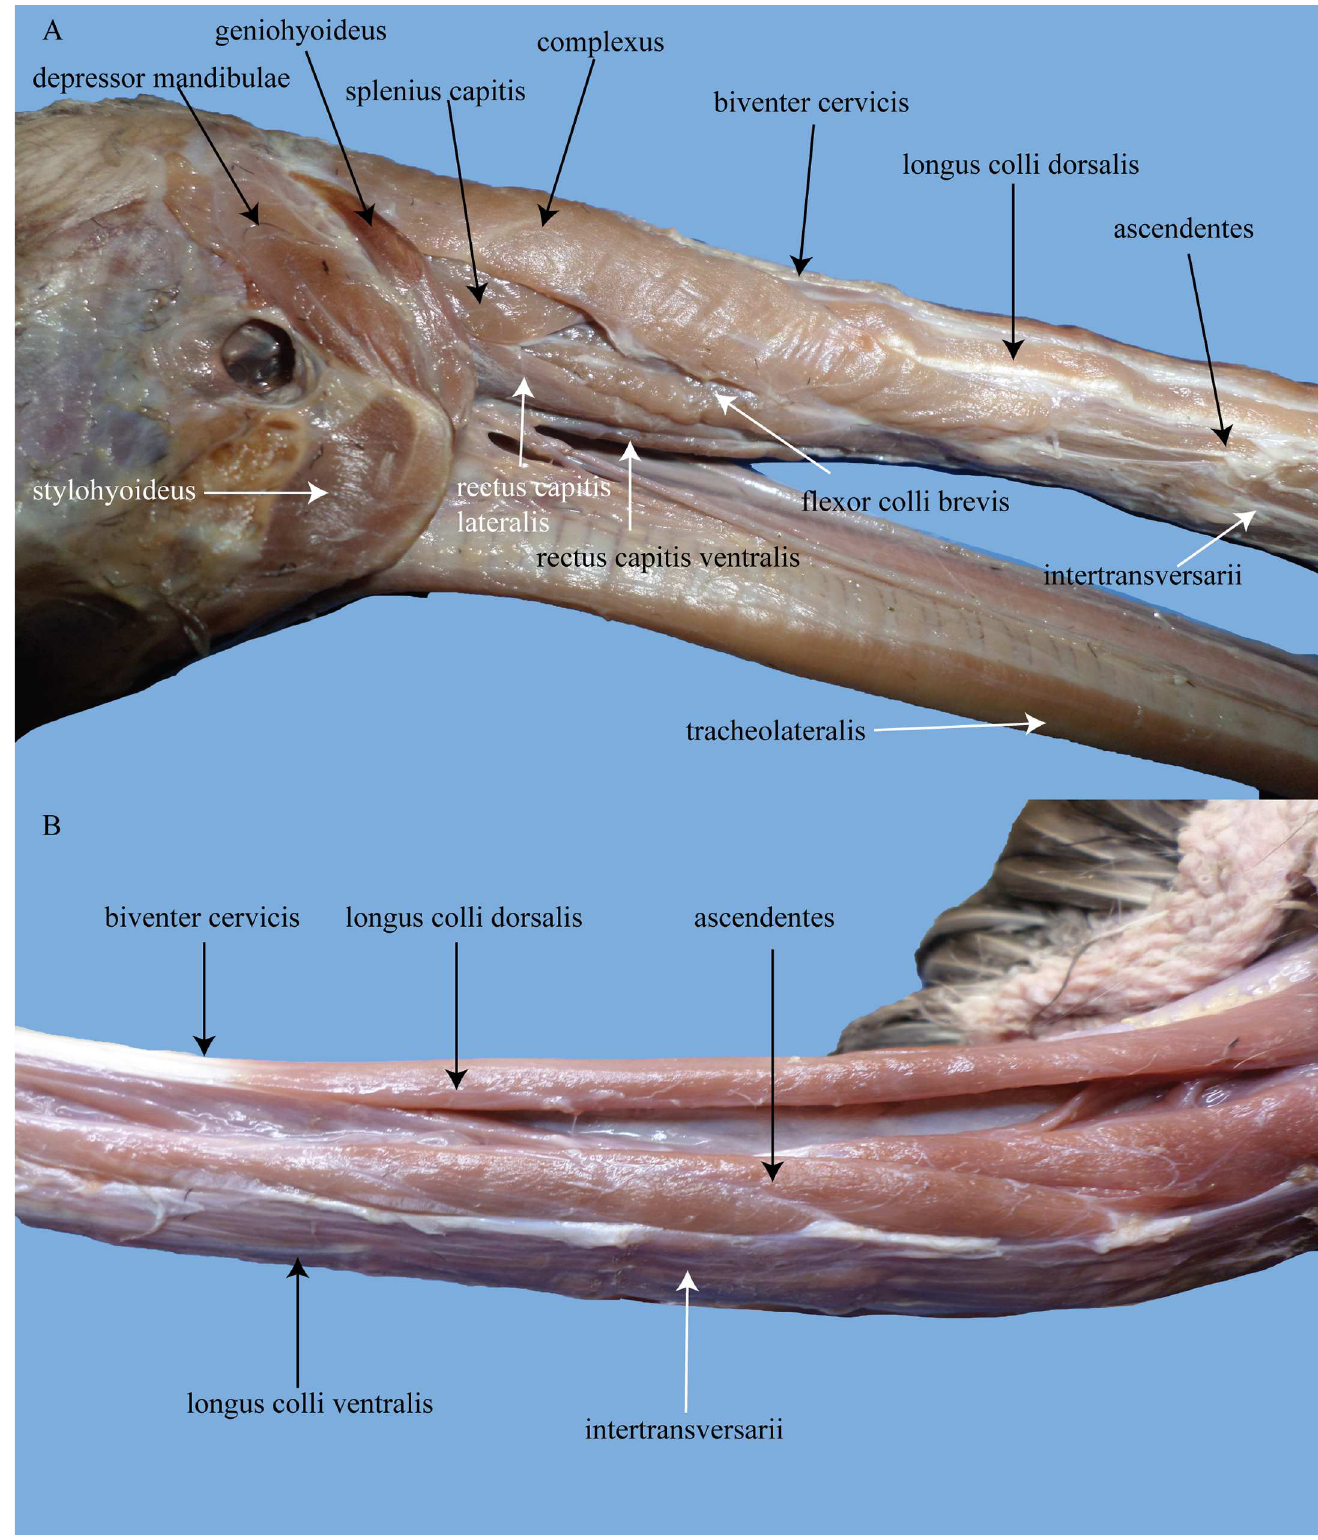
Fig 13. Lateralviews of the cervicalmusculature of Brantacanadensis . (A) anteriormuscles. (B) posteriormuscles.